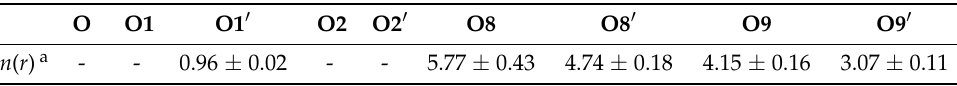
Table 4. ∆ G bind, MM/PBSA and its energy components (kcal/mol) of the AA/DM β CD complex.